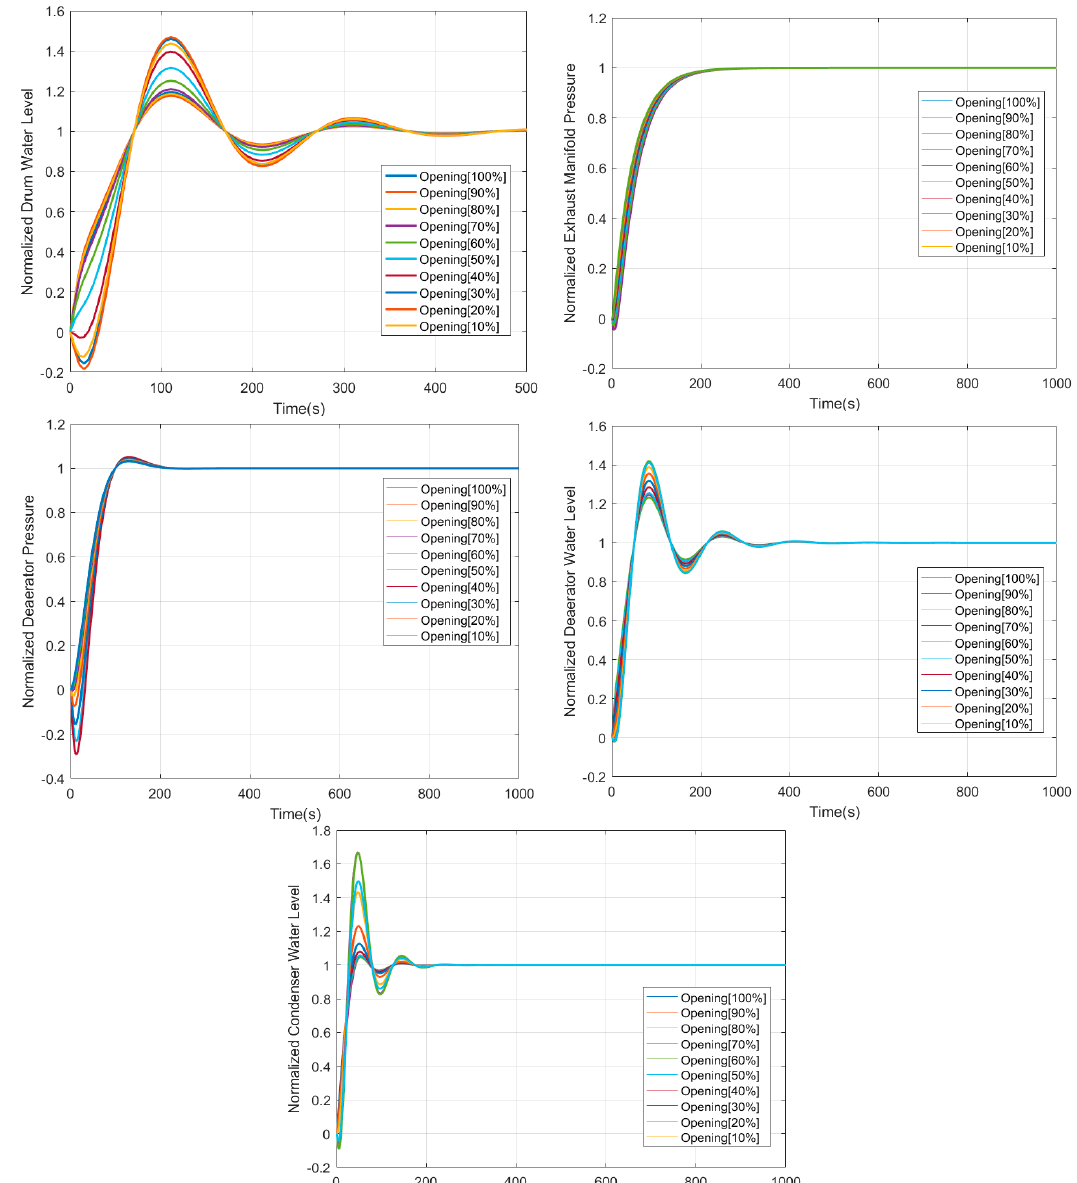
Figure 2. The normalized outputs of the steam/water loop with 10% step change in the input variables.